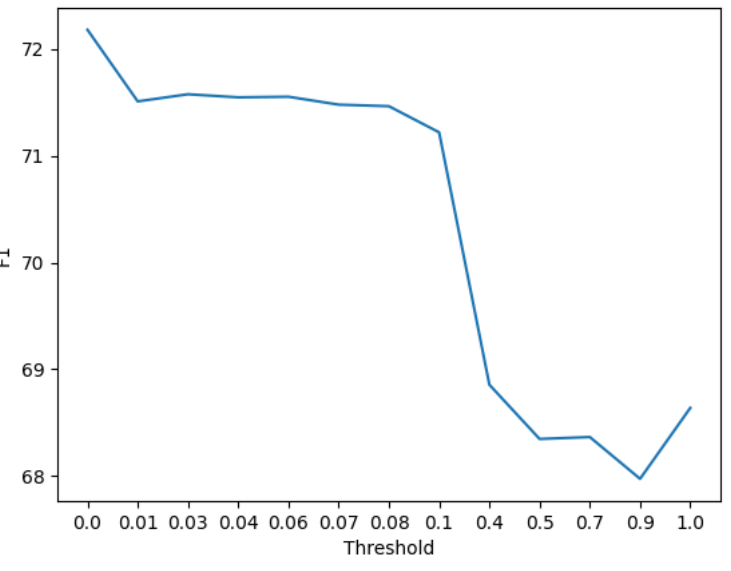
Figure 6. F1-scores of relation extraction on the CoNLL04 dataset when using different threshold. The wonderful vaule occurs in 0–0.1 threshold range, particular at 0.